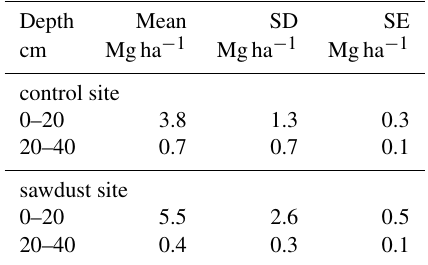
Table A1. Gravimetric-determined rooting intensity, measured with five 2.7dm 3 corers at each site.